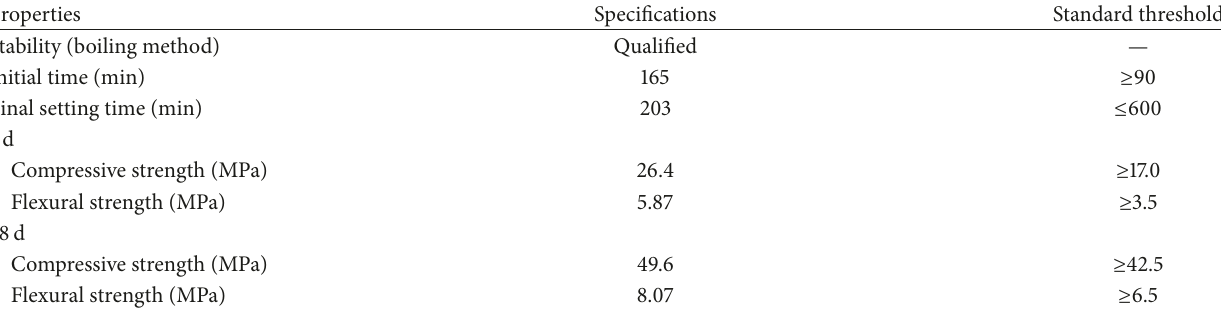
Table 1: Specifications of the ordinary Portland cement type